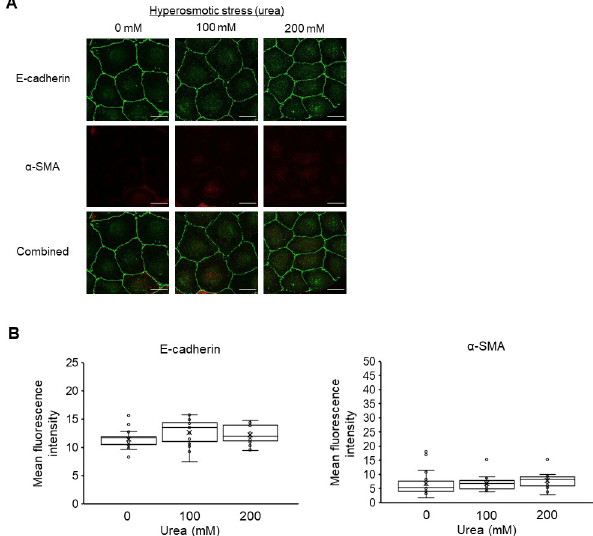
Fig 3. Effects of hyperosmotic urea stress on the epithelial-mesenchymal transition (EMT) of NRK-52E cells. (A) Typical fluorescence images of E-cadherin (green), α -SMA (red), and combined (green and red) cultured with 0, 100, and 200 mM urea for 12 h. Bar, 25 μ m. (B) Quantitation of the changes in the mean fluorescence intensities of E- cadherin and α -SMA (n = 19 from 0 mM, n = 19 from 100 mM, n = 19 from 200 mM) by immunofluorescence staining. Data are presented as box and whisker plots with average ( × ), median, IQR, and minimum and maximum values. The n indicates the number of independent experiments.